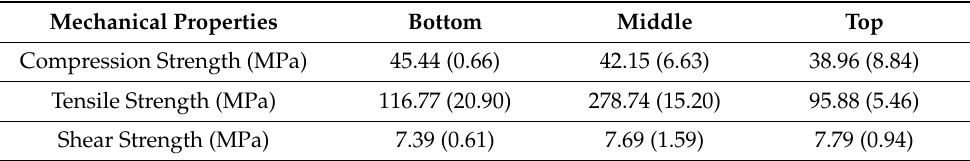
Table 7. Mechanical properties of Gigantochloa pruriens